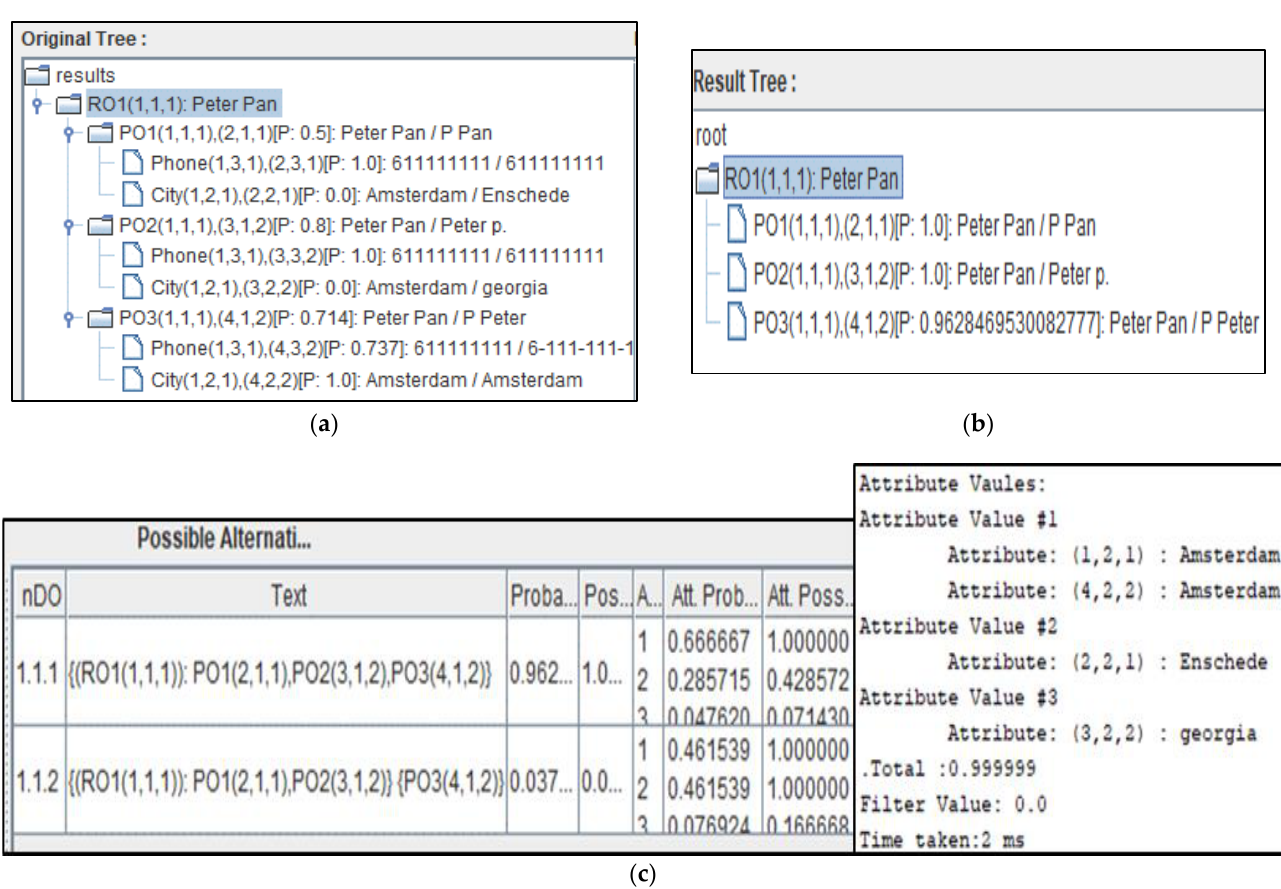
Figure 6. The updated-City data fusion alternatives’ example is based on the newly added evidence from the fourth data source. ( a ) The participated entities with their original matching tree. ( b ) The probabilistic entities linkage/merging results. ( c ) The possible data fused values for City attribute at each possible entities merging alternative as produced based on Figure 6b.